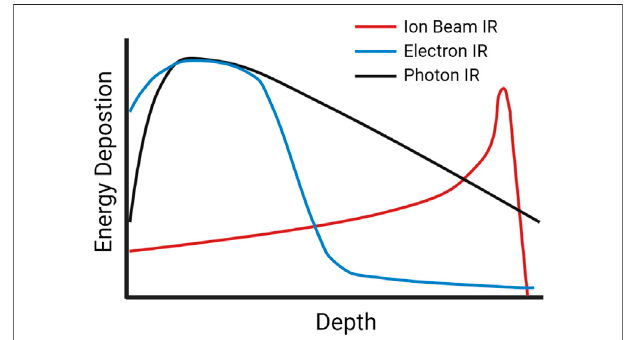
FIGURE 1 | A schematic of dose-depth curves of ion beams and low- LET photon and electron radiation illustrating the difference in peak energy deposition as the radiation travels through